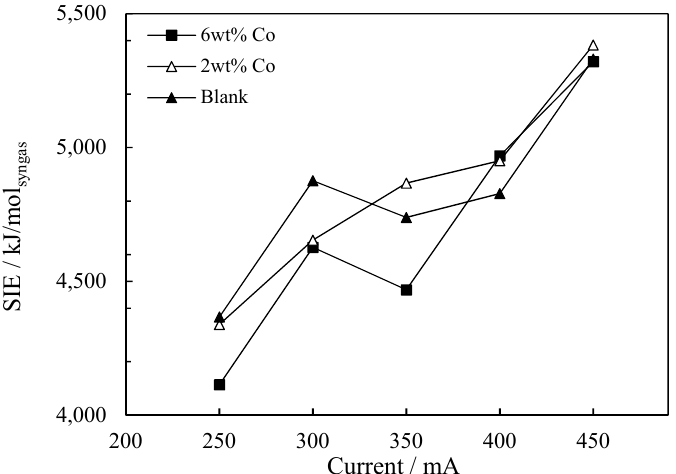
Figure 9. Specific input energy (kJ/molsyngas) as a function of current for plasma-catalytic FTS (NTP + Blank, 2 or 6 wt% Co catalyst) at a discharge time of 60 s. Legend: ■ —6 wt% Co; Δ —2 wt% Co; ▲ —Blank. Operating conditions: Syngas (H 2 /CO) ratio: 2.2:1; pressure: 2 MPa; inter-electrode gap: 1 mm; wall temperature: 25 °C.